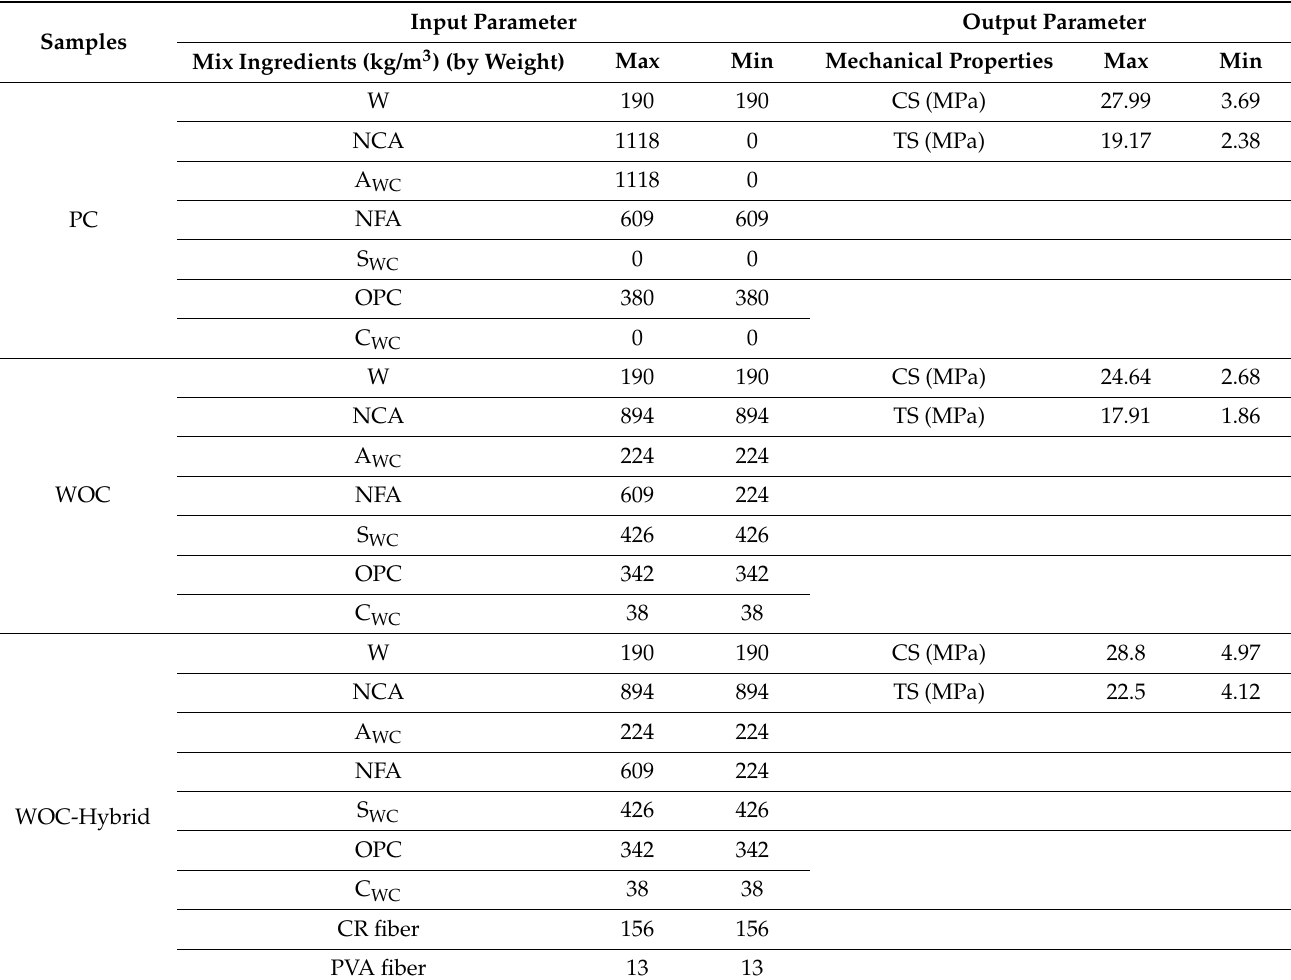
Table 8. The input and output parameters used in ANN training.